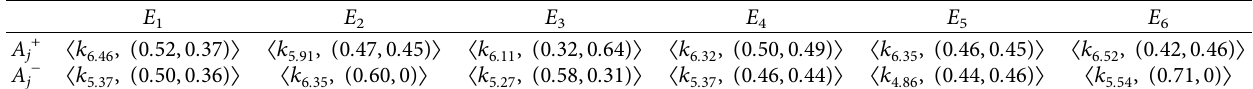
Table 9: Positive ideal solution (PIS) and negative ideal solution (NIS) for each